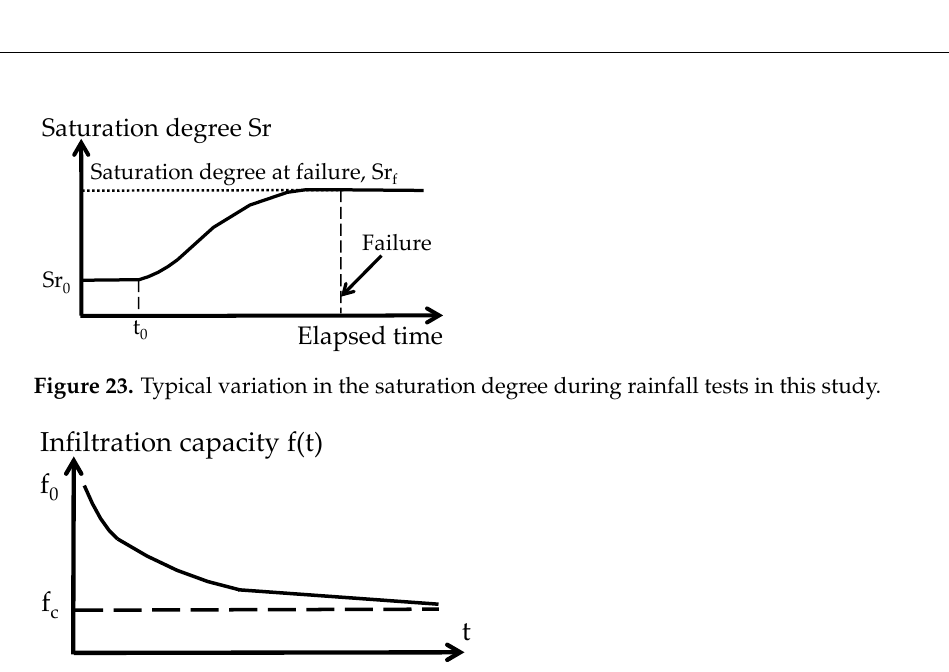
Figure 24. Diagram of soil infiltration capacity during rainfall based on Horton’s concept [38].